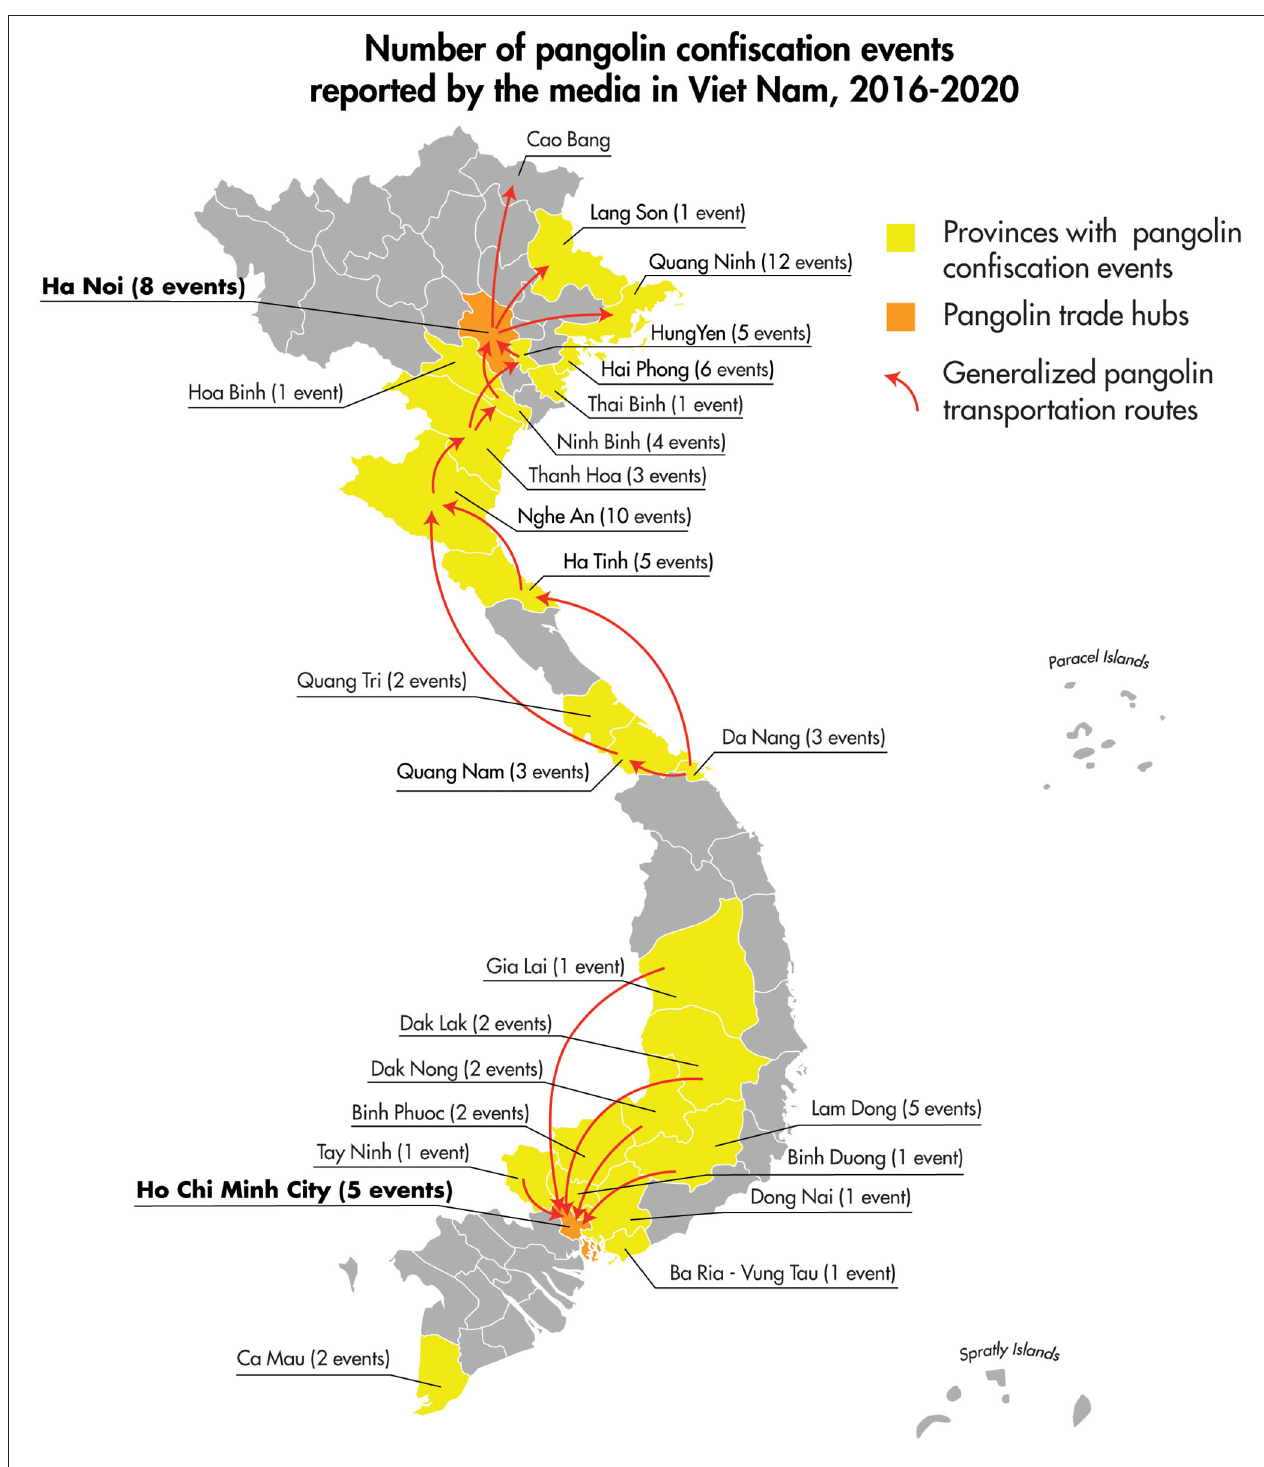
FIGURE 5 | Location and number of pangolin confiscation events, and generalized depiction of domestic transport routes as reported in the public media for the period of January 2016–December 2020. Civet Sarbecovirus Screening Civets (Viverridae) are raised in captivity on wildlife farms in Viet Nam and traded commercially between farms and through